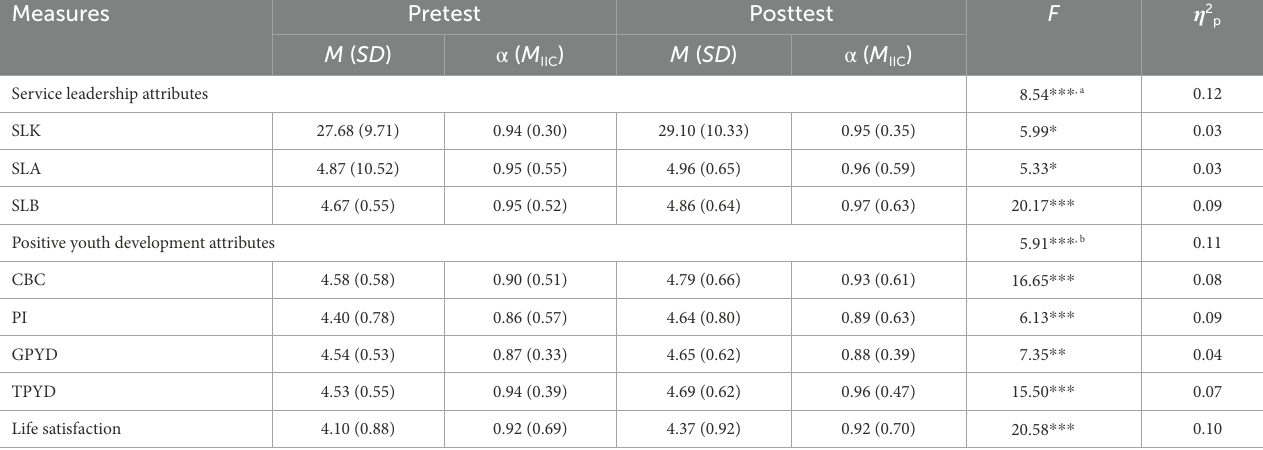
TABLE 1 Reliability of measures and participants’ changes from the pretest to posttest ( N = 198).